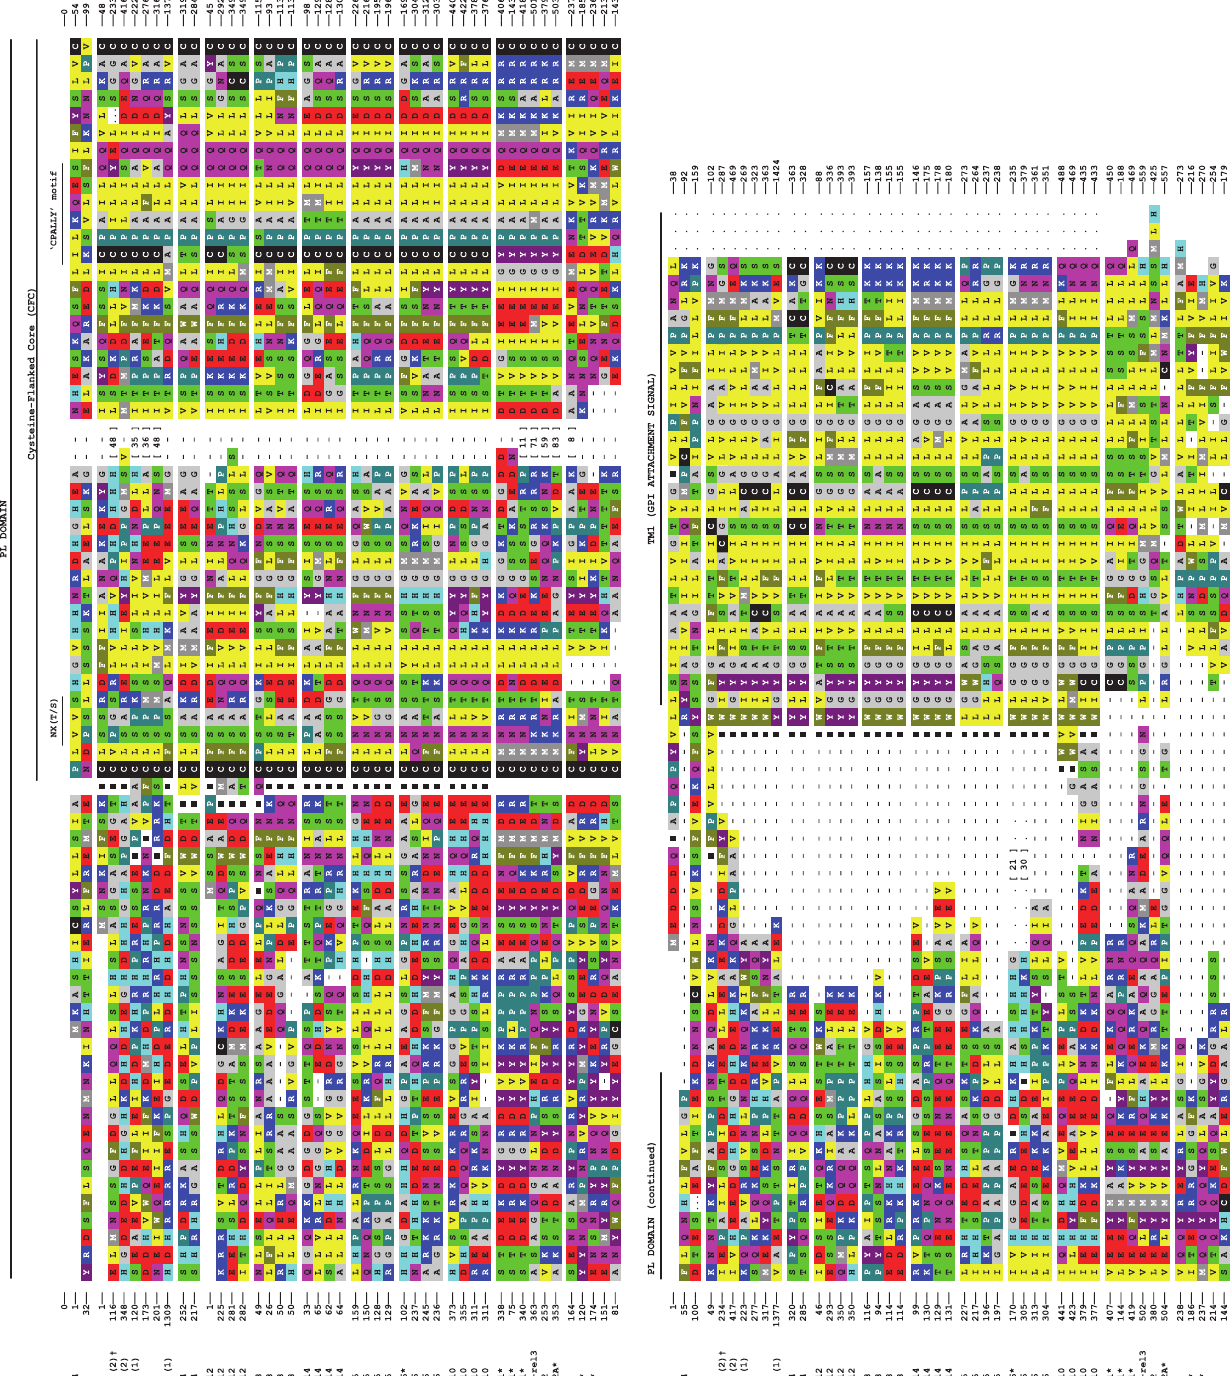
Figure 2. The cysteine-flanked core within the prion-like domain of ZIP proteins is confined to metazoa. Multiple sequence alignment of the prion-like domain of select PrP and ZIP genes from metazoans to mammals. Baker’s yeast (Sc_YKE4), fission yeast (Sp_ZIP) and choanoflagellate (Mb_ZIP) sequences were included in this alignment in the interest of depicting a small number of representative LZT protein sequences outside of the metazoa realm. Their ectodomains appear, however, to lack a CFC domain based on (i) poor alignment, (ii) the absence of a ‘CPALLY’ motif and (iii) the absence of conserved introns. Black squares ( & ) indicate the position of introns and asterisks (*) denote sequences for which complete intron/ exon annotations were not available. Numbers in square brackets ([X]) indicate the length of a stretch of amino acids omitted for the purpose of clarity in a specific section of the alignment. Please note that Dm_ZIP (2) (marked with dagger symbol { ) is the same protein sequence as that encoded by the Drosophila melanogaster fear-of-intimacy ( foi ) gene. Please see Table S2 for a complete list of scientific and common names of species referred to in this alignment with two-letter abbreviations.